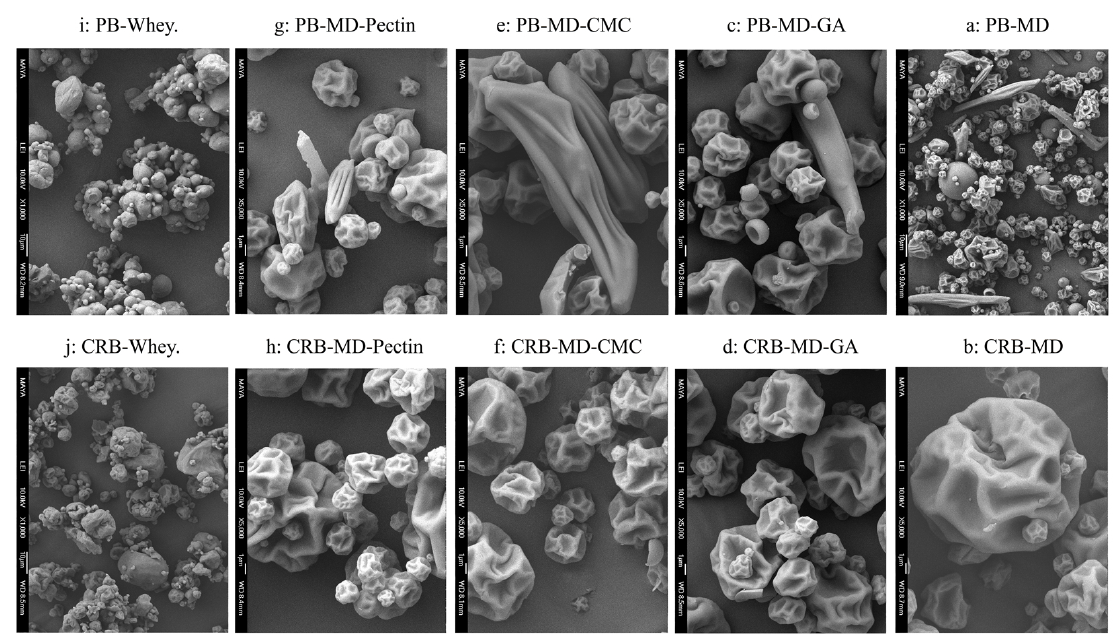
Figure 4. SEM images of Spray Dried bixin microcapsules using different wall materials. Left column corresponds to PB (bixin crystals) microcapsules whereas right column shows CRB (Carbohydrate rich bixin extract) microcapsules. Non-encapsulated colorant crystals can be observed when the native carbohydrates of the annatto extract are absent. Systems